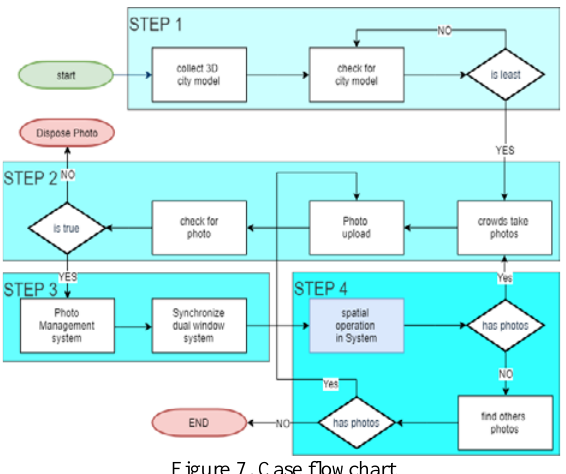
Figure 7. Case flowchart